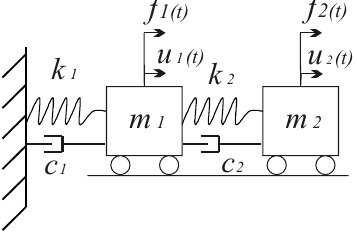
Fig. 1. Two d.o.f. system